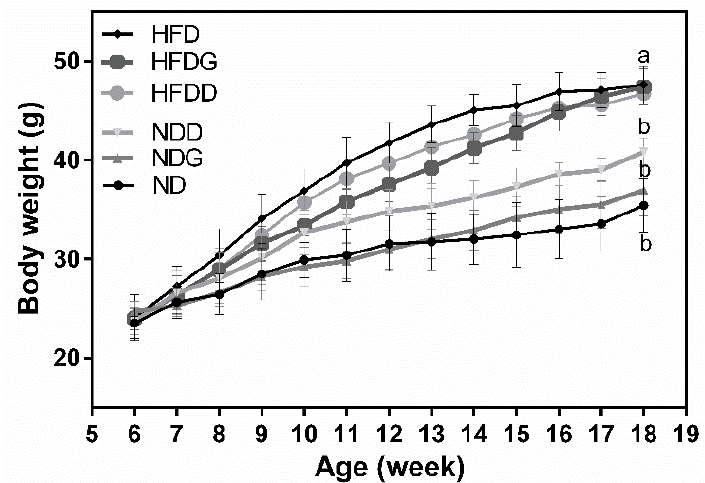
Figure 1. Effects of garlic supplementation on mice body weight. Results are expressed as the mean ± SD for each group of rats ( n = 5). The body weights at 18 weeks with different letters significantly differ ( p < 0.05). HFD: high-fat diet; HFDG: 5% garlic in HFD; HFDD: 4% dextrin in HFD; ND: normal diet; NDG: 5% garlic in normal diet; NDD: 4% dextrin in normal diet.